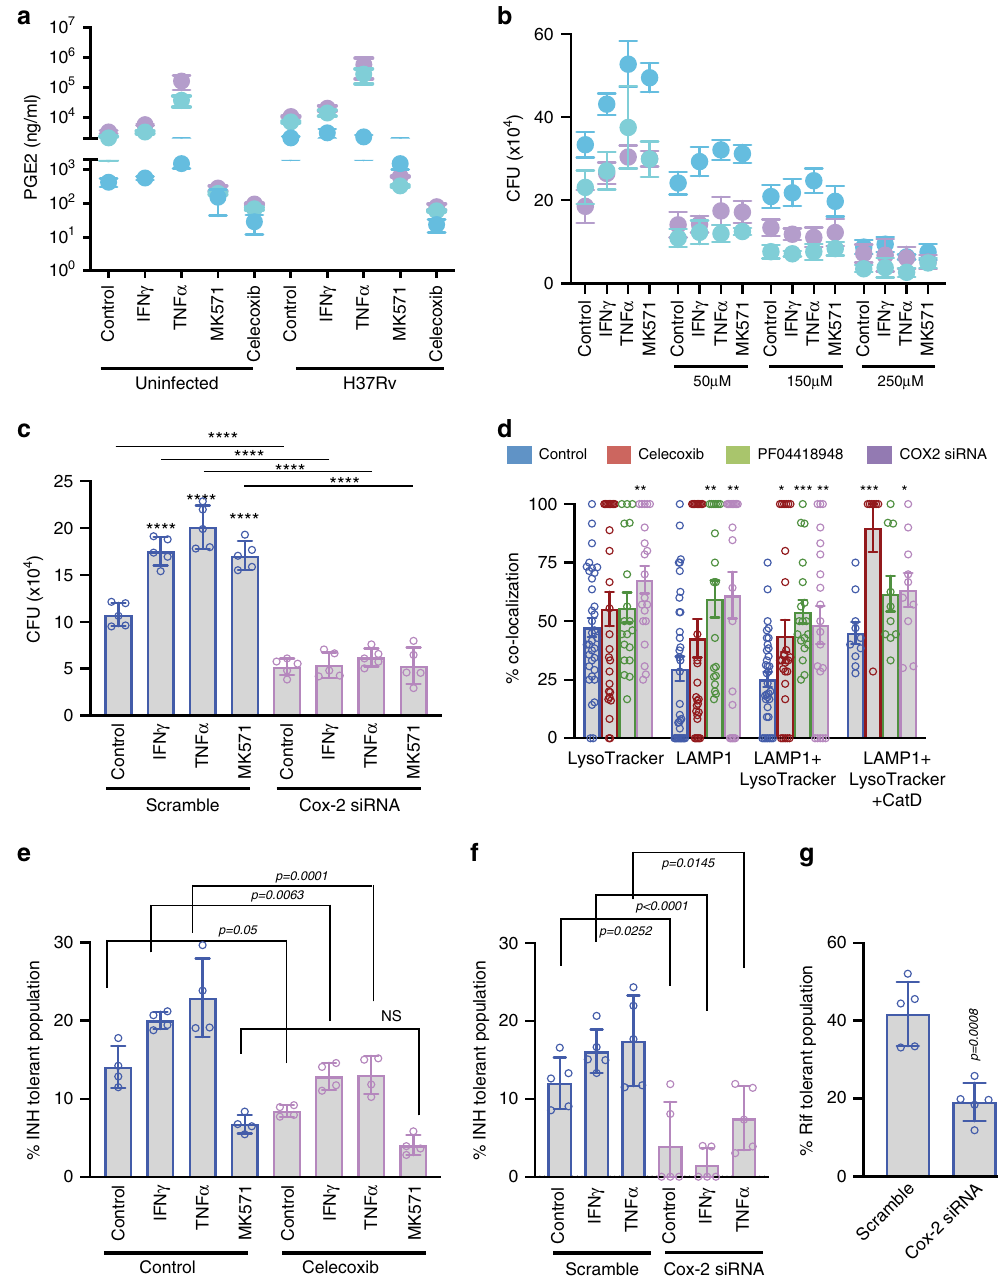
Fig. 3 Lipid mediator PGE2 modulates lysosomal activity in Mtb -infected ADSCs. a Uninfected or H37Rv -infected ADSCs were either untreated or treated with IFN γ , TNF α , MK571 and celecoxib (250 µ M, negative control) for 24h before collecting supernatant for ELISA on 6th dpi (6th day post seeding in the uninfected cells), Mean±SD, n = 3 donors represented by three colors. b CFU enumeration of H37Rv -infected ADSCs treated with different doses of celecoxib (50 µ m, 150 µ M, 250 µ M) in addition to IFN γ , TNF α , or MK571 for 24h before plating on 6th dpi, Mean±SD, n = 3 donors represented by three colors. c H37Rv -infected ADSCs treated with Cox-2 siRNA or scramble siRNA (100nM) along with 24h treatment with IFN γ , TNF α , or MK571 prior to CFU plating on 6th dpi, Mean±SD, n = 5. d Percent Colocalization of H37Rv with LysoTracker Red, LAMP1, and Cathepsin D stained compartments in ADSCs left untreated or treated for 24h with Celecoxib (250 µ M), PF04418948 (500nM), or Cox-2 siRNA (100nM, 48h) before fi xing samples on 3rd dpi, Mean±SEM, n = 3. e , f Percent INH-tolerant population in ADSCs treated with celecoxib ( e , n = 4) or Cox-2/scramble siRNA ( f , n = 5) along with IFN γ , TNF α or MK571 addition for 24h prior to CFU plating on 6th dpi, Mean±SD. g Percent RIF-tolerant bacterial population in infected ADSCs treated with scrambled or cox-2 siRNA (100nM) for 48h prior to CFU plating on 6th dpi, Mean±SD, n = 5. Data were analyzed using two-tailed unpaired Student ’ s t test ( a , c , d , f , g ) and one-way ANOVA ( b , e ). * P <0.05, ** P <0.005, *** P <0.0005, **** P <0.0001, NS ‘ not signi fi cant ’ Source data are included in the source data fi